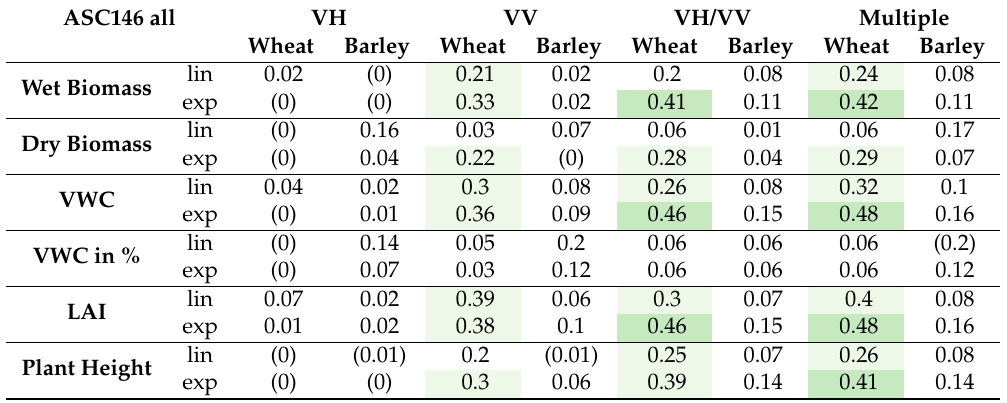
Table 3. R 2 values of the regression between crop and backscatter parameters per crop type for all fields. Values in parentheses are not significant ( p > 0.01).